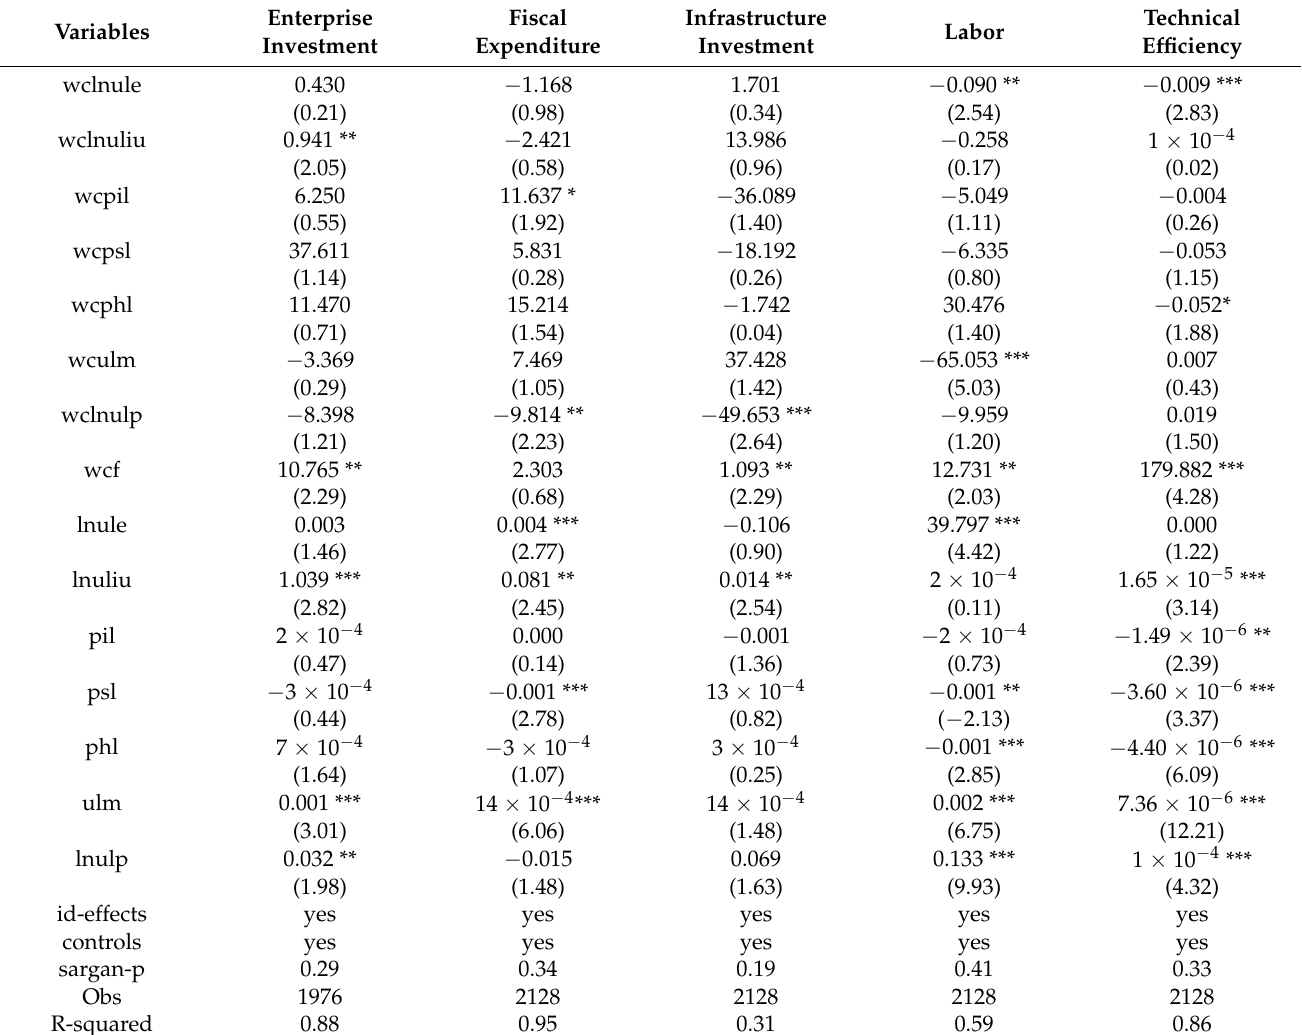
Table 4. Estimation results for the intermediate mechanism of the ULUT affect the ESSCC in urban agglomerations. Enterprise Variables